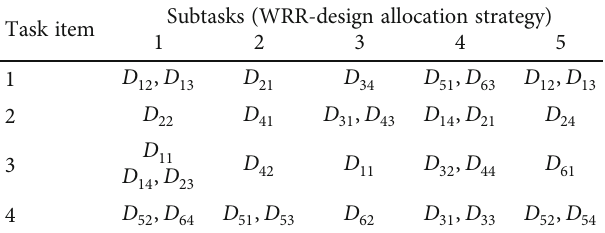
Table 20: WRR-design allocation strategy. Task item